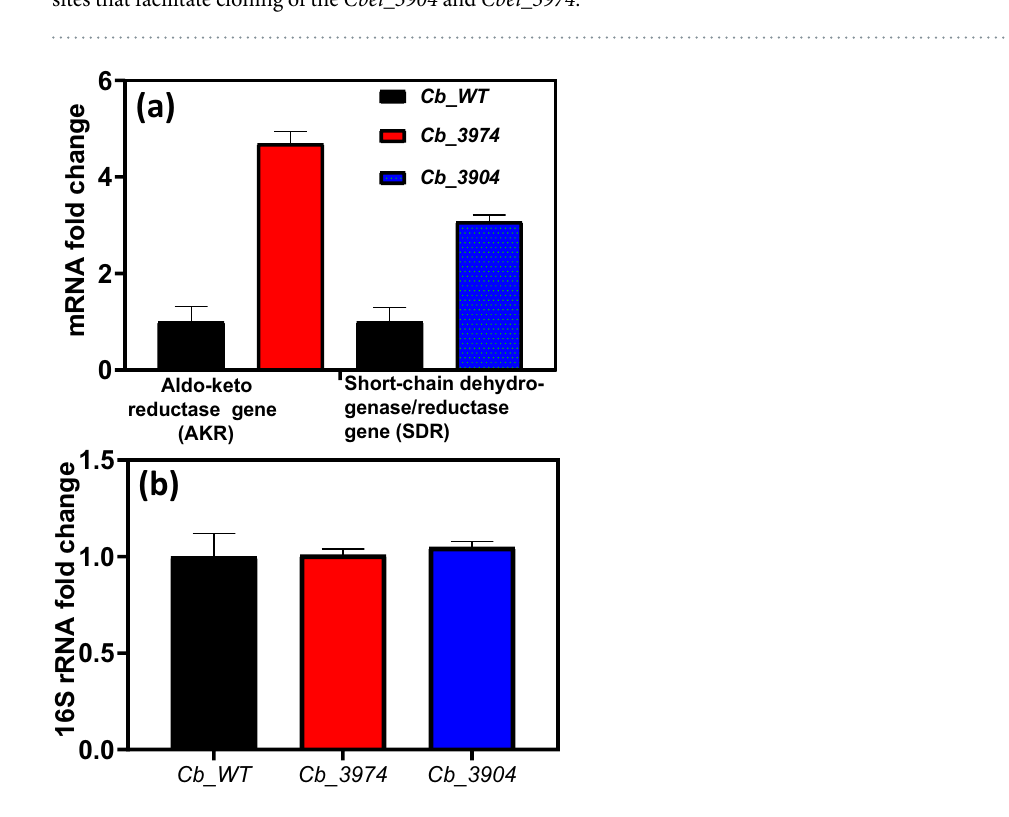
Table 1. List of PCR primers and PCR strategies. Underlined nucleotides (sequence) indicate ribosome binding sites that facilitate cloning of the Cbei_3904 and Cbei_3974 .